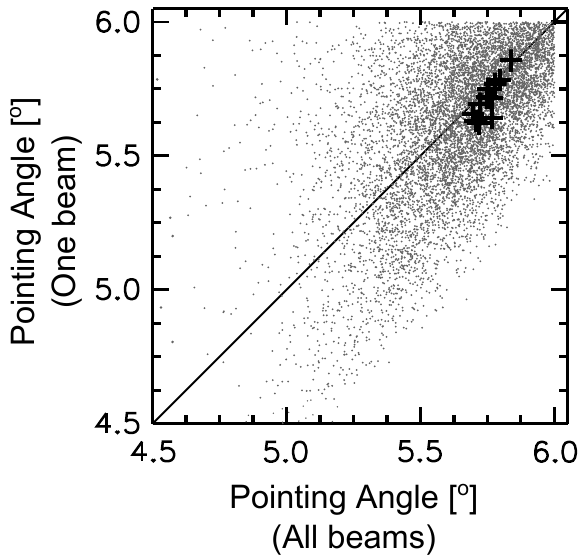
Figure 9. Effective pointing angles derived from 8 weeks of special radar operation, using all 4.2 ◦ zenith beams ( x axis), and the 252.5 ◦ azimuth 4.2 ◦ beam ( y axis). The grey dots are pointing angles from hourly averages, and the pluses are averages over the whole 8 weeks of operation. The solid line traces the 1:1 points. Only results for every third height gate between 4 and 9km are shown, to aid inter-